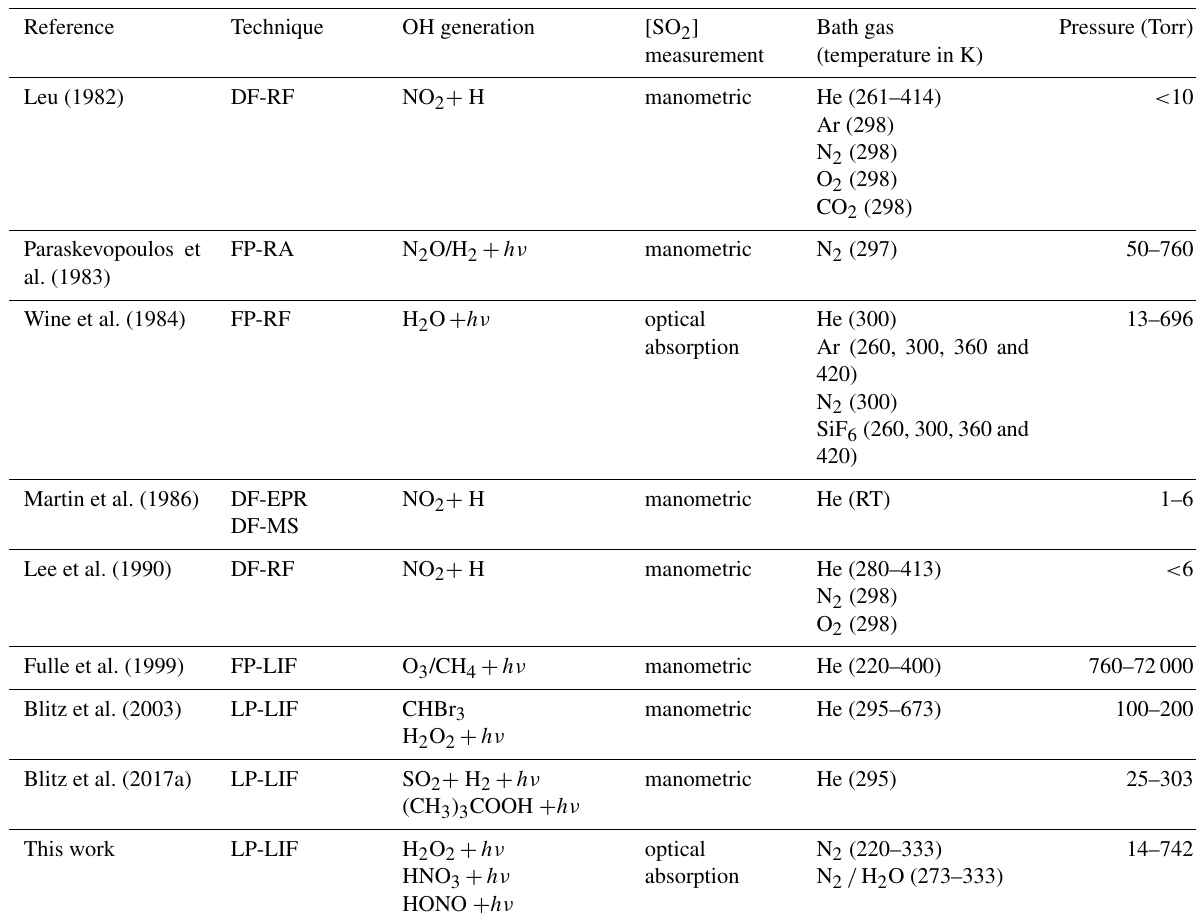
Table 1. Temperature- and pressure-dependent measurements of k 1